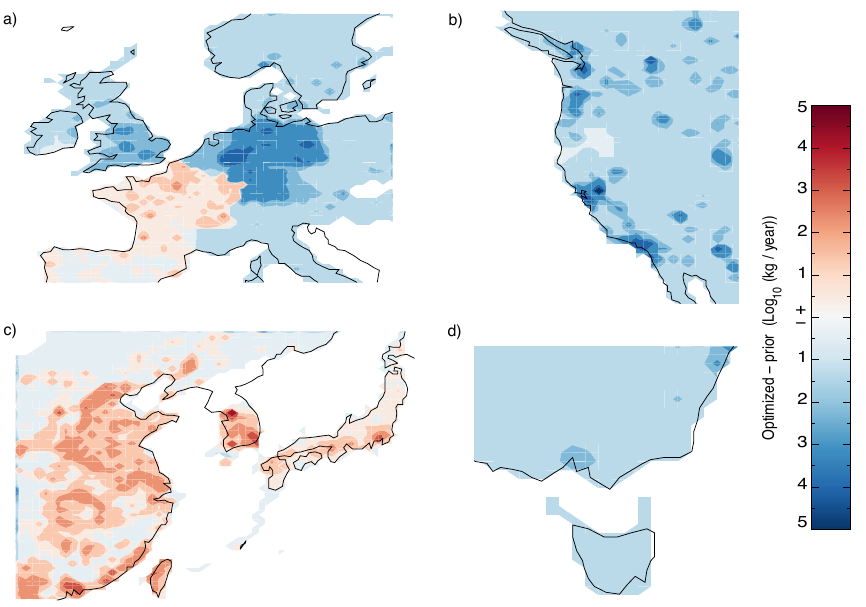
Fig. 6. Difference between optimized and prior SF 6 emissions surrounding (a) Mace Head, Ireland, (b) Trinidad Head, California, (c) Gosan, South Korea, (d) Cape Grim, Tasmania. Red and blue colors indicate that the optimized values are higher and lower than the prior